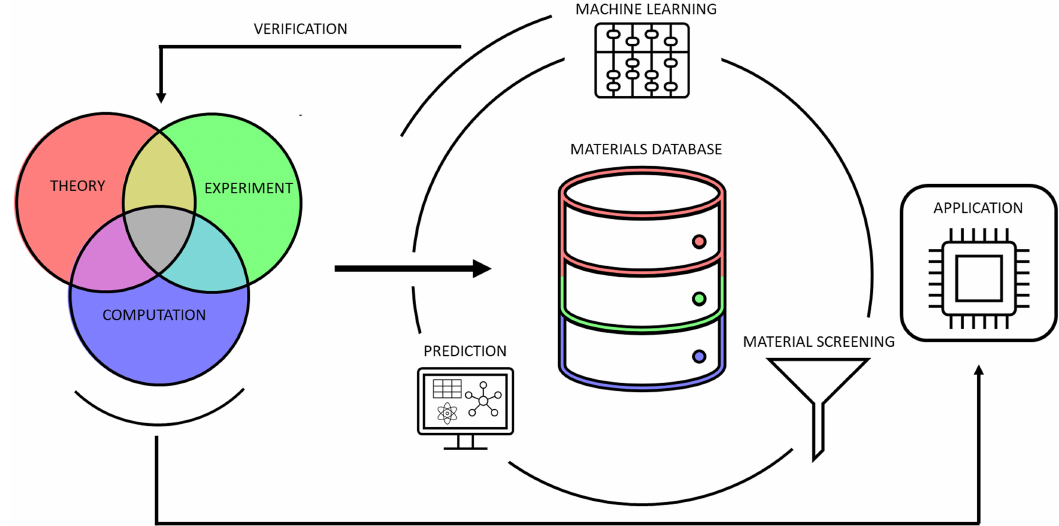
Fig. 1 Schematic of an example work fl ow in material informatics. Results from theory, experiment and computation are fed into material databases (arrow pointing to the center). A cycle involving material screening, machine learning and predictions leads to knowledge gain and ultimately applications in fi elds such as clean energy and quantum